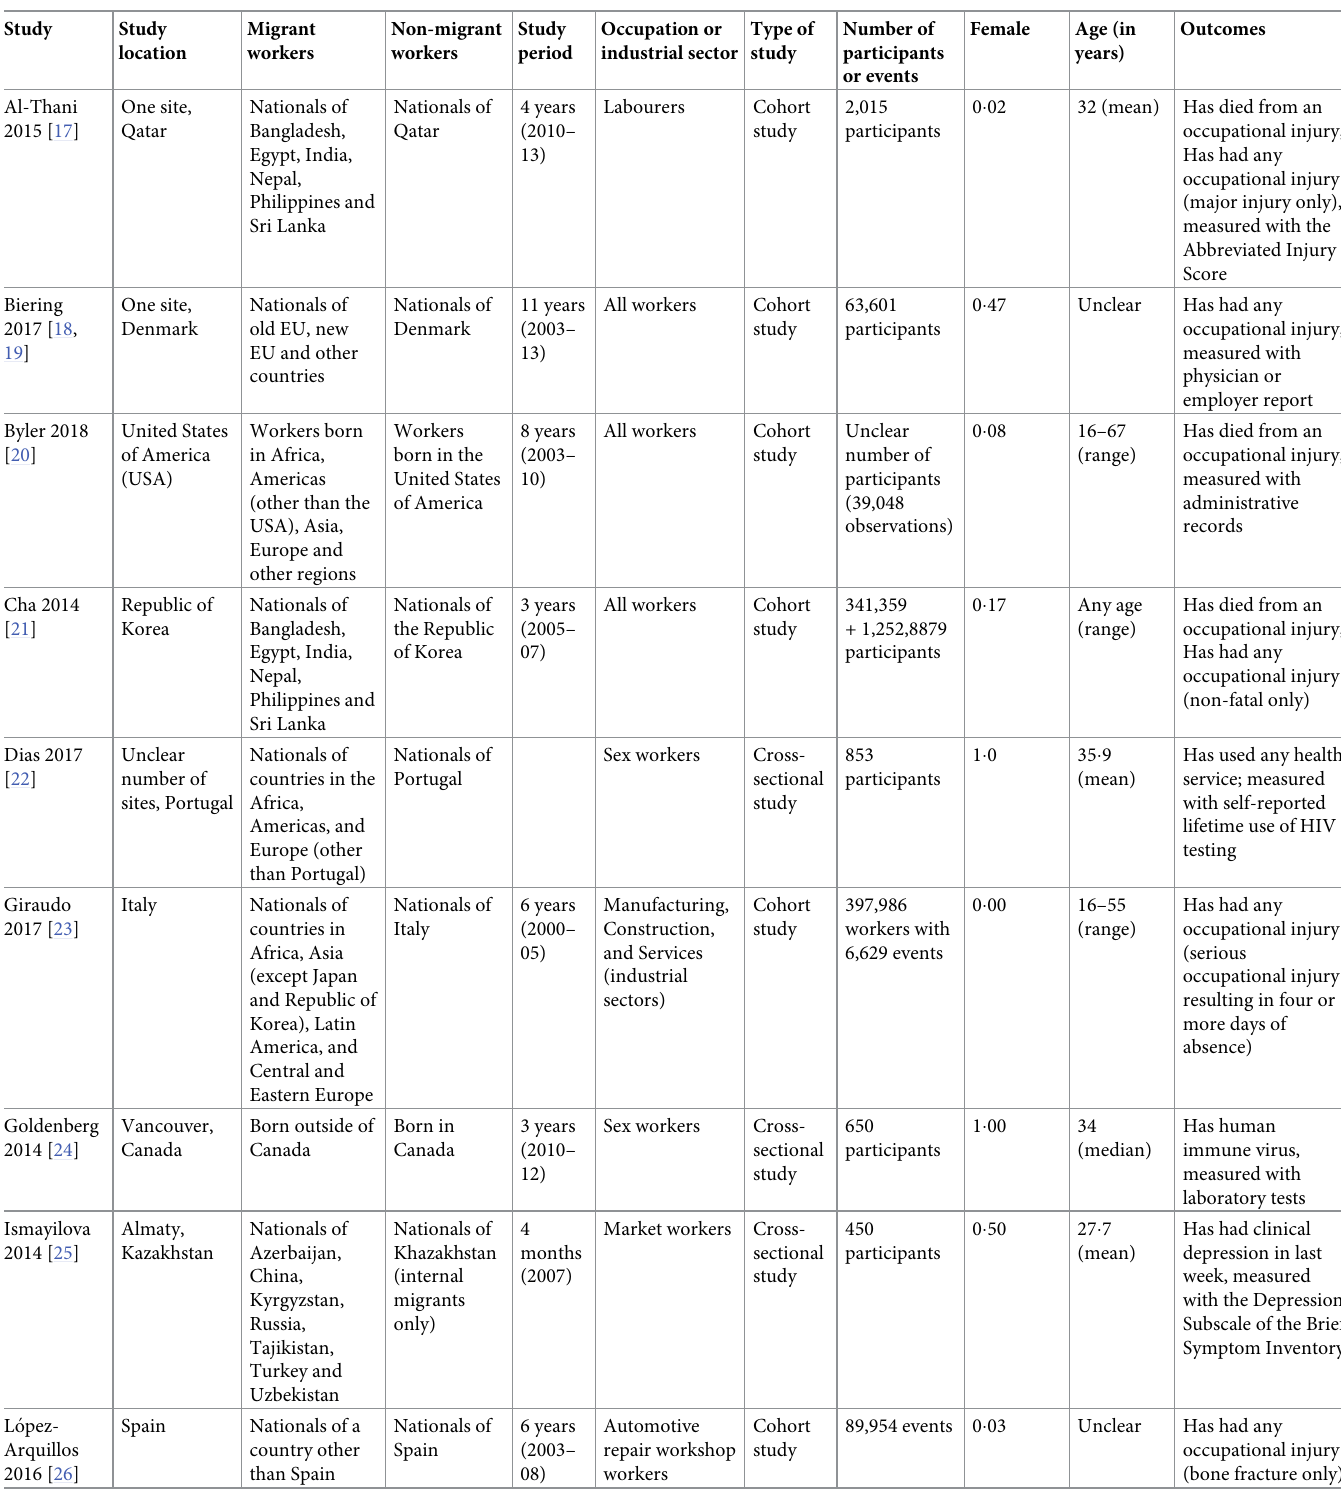
Table 1. Characteristics of included